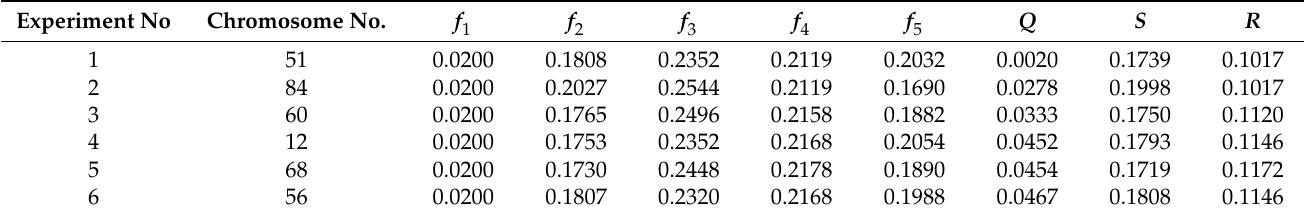
Table 11. Information on the 6 schemes with the best Q -value sorting.